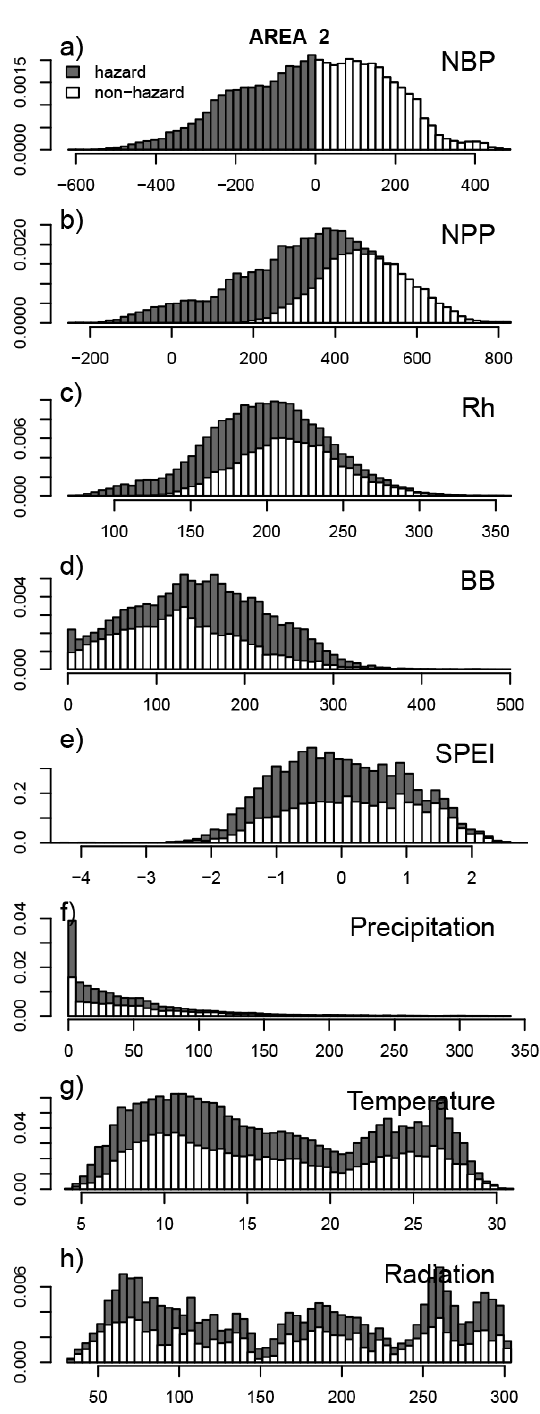
Figure B3. Probability distributions for area 2 (see Fig. B1) of (a) NBP and its contributions (b) NPP, (c) Rh, and (d) BB (all in gCm − 2 a − 1 ) as well as monthly values for (e) SPEI (dimen- sionless), (f) precipitation (mmmonth − 1 ), (g) temperature ( ◦ C) and (h) short-wave downward radiation (Wm − 2 ). Dark shading denotes values in the hazard group, white shading in the non-hazard